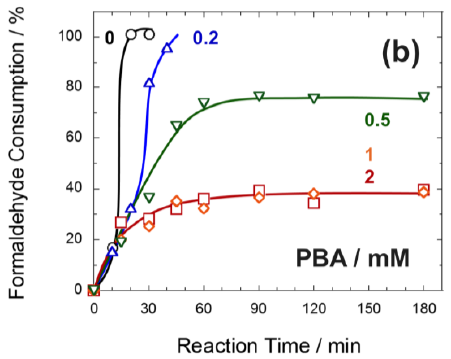
Figure 2. Time–conversion plots for the formose reaction carried out using 1 M formaldehyde and 120 mM calcium hydroxide at 60 °C in the presence of 0 (black circle), 0.2 (blue triangle), 0.5 (green inverted triangle), 1 (orange diamond), and 2 mM (red square) PBA ( a ) and 0 (black circle), 1 (blue triangle), 5 (orange diamond), and 10 g·L −1 (red square) pDMA/VBA ( b ). The same colors indicate the same concentrations of boronic acid moieties. The curves are drawn as a guide for the eye.